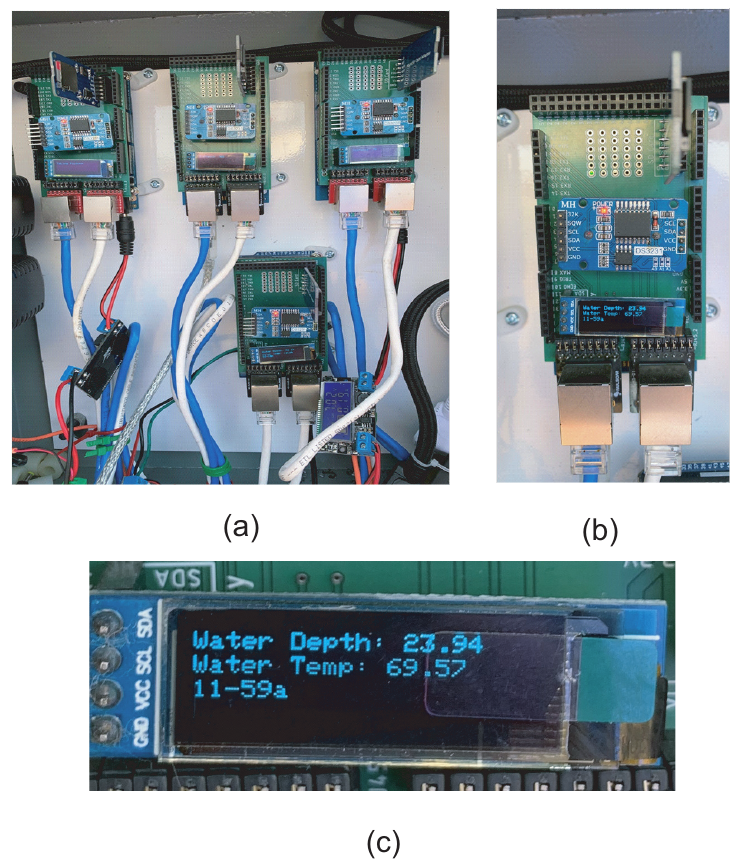
Figure 11. The central electrical box implemented for four drinking stations. ( a ) Four Arduino boards for each drinking station. ( b ) An Arduino boards with breakout boards. ( c ) Water information display on an LCD